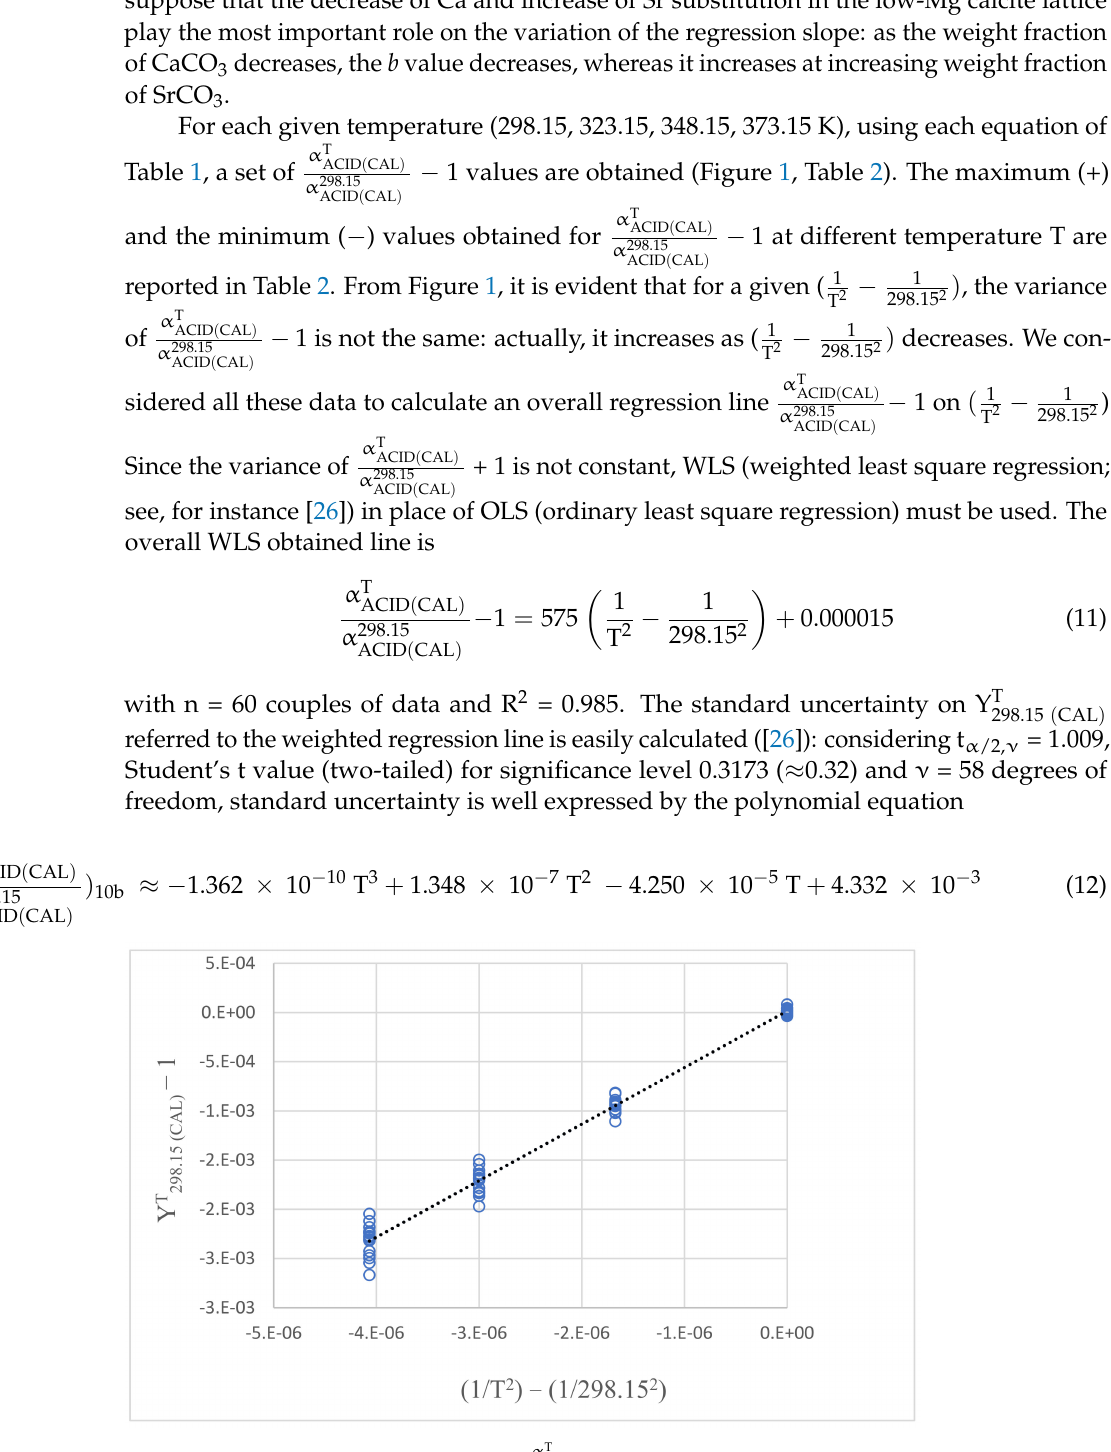
α T ACID ( CAL ) − 1 = − 1 on ( 1 − 1 ) for the values Y T 298.15 ( CAL ) α 298.15 298.15 2 T 2 ACID ( CAL ) − 1 ) value 298.15 2 T 2